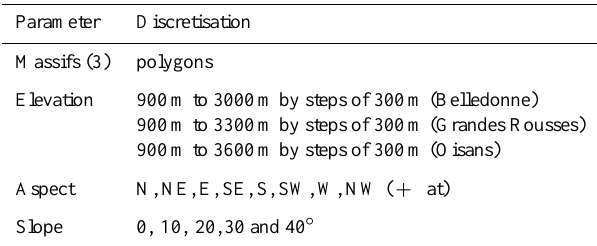
Table 2. Discretisation of the SAFRAN-Crocus topographic param- eters on our study